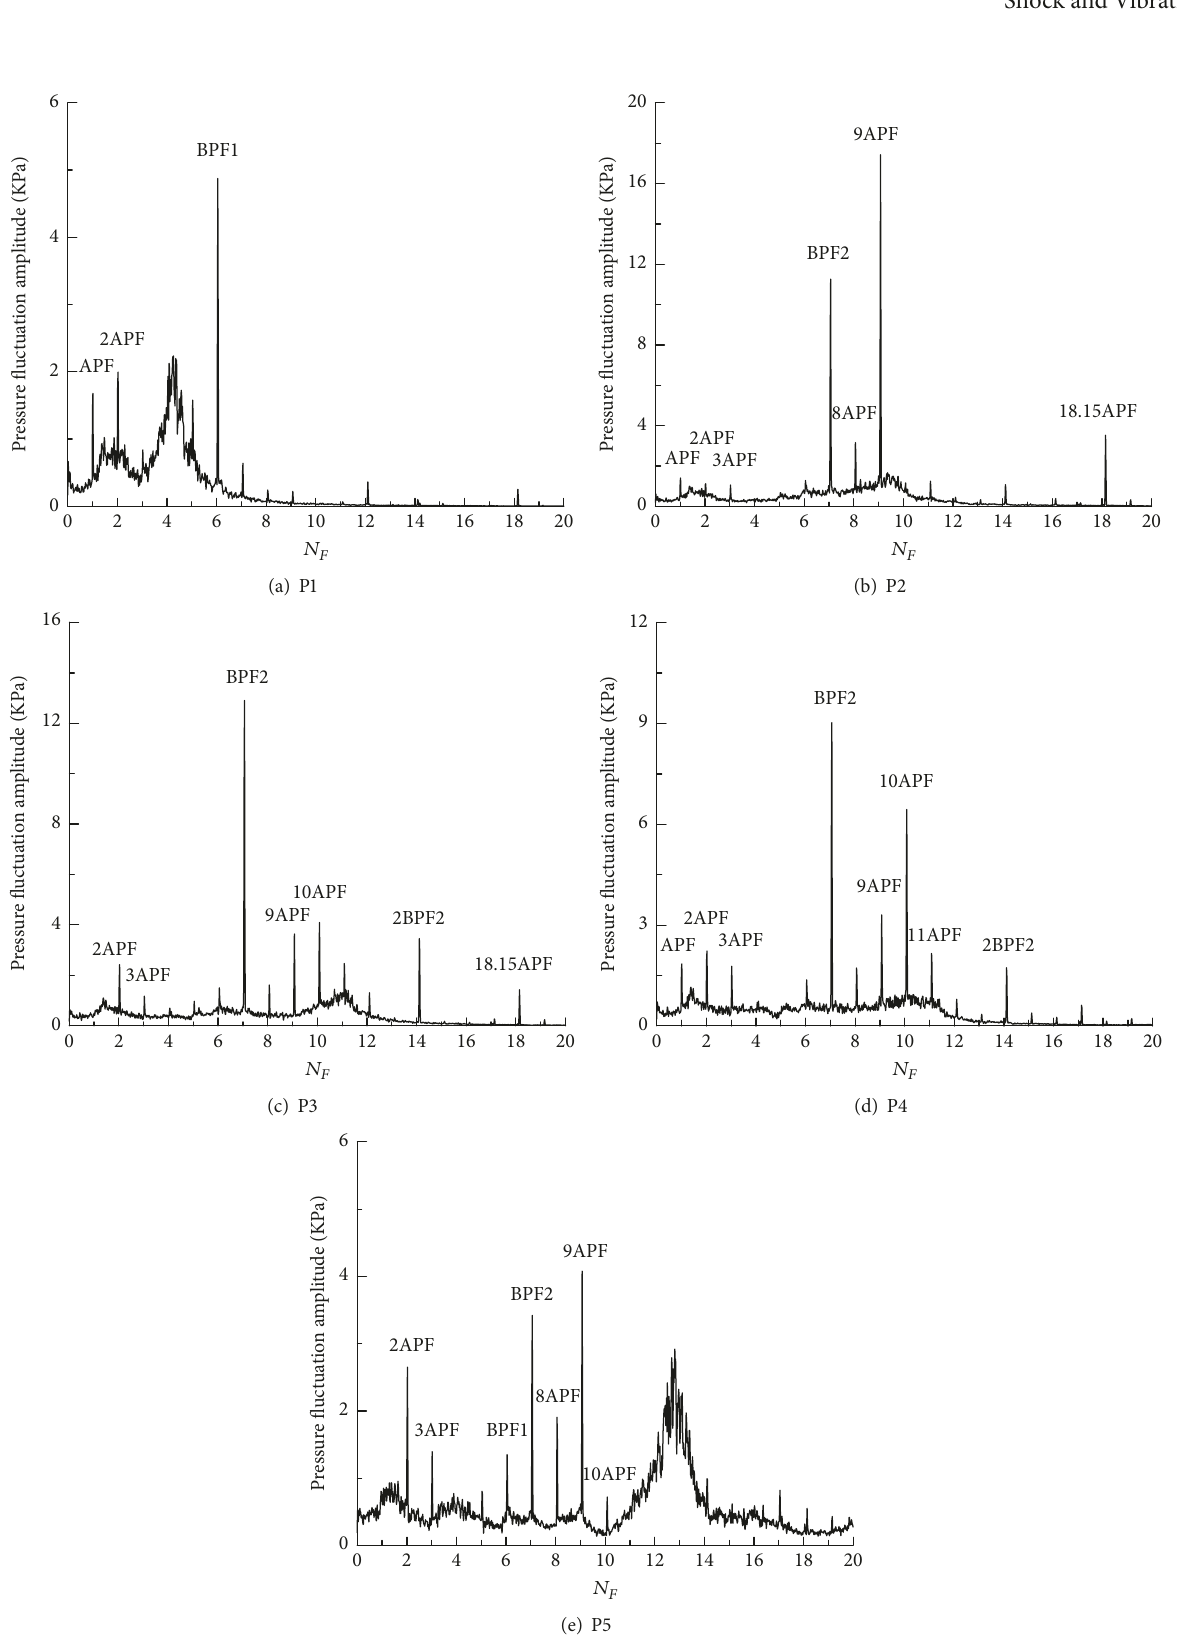
Figure 6: Spectrogram of pressure fluctuation under design flow